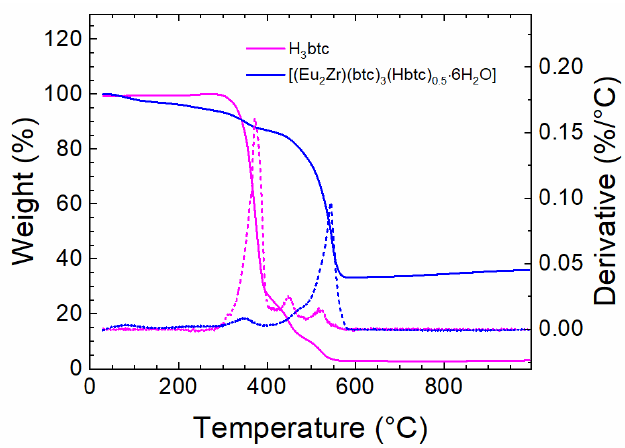
Figure 3. TGA curves (solid lines) for [(Eu 2 Zr)(btc) 3 (Hbtc) 0.5 · 6H 2 O)] and H 3 btc represent the succes- sive mass losses. The derivatives of the TGA curves are shown as dashed lines.